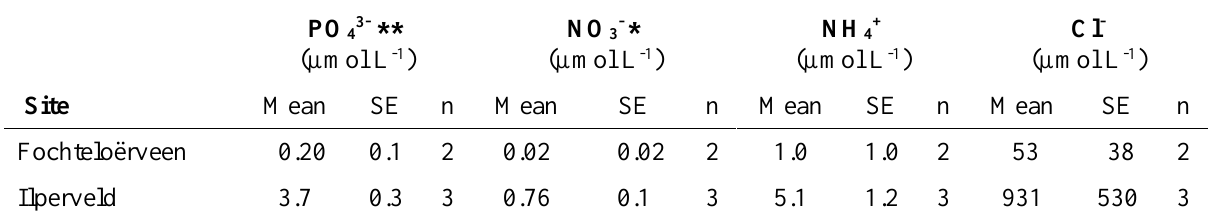
Table A3. Results of the elemental analysis of the pore water with the autoanalyzer. Differences between sites were tested with independent t-test. Significant differences are indicated in the column header using *.